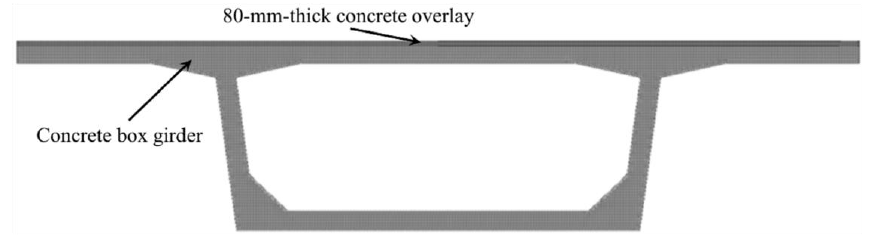
Figure 10. Finite element model of cross-section of box girder.